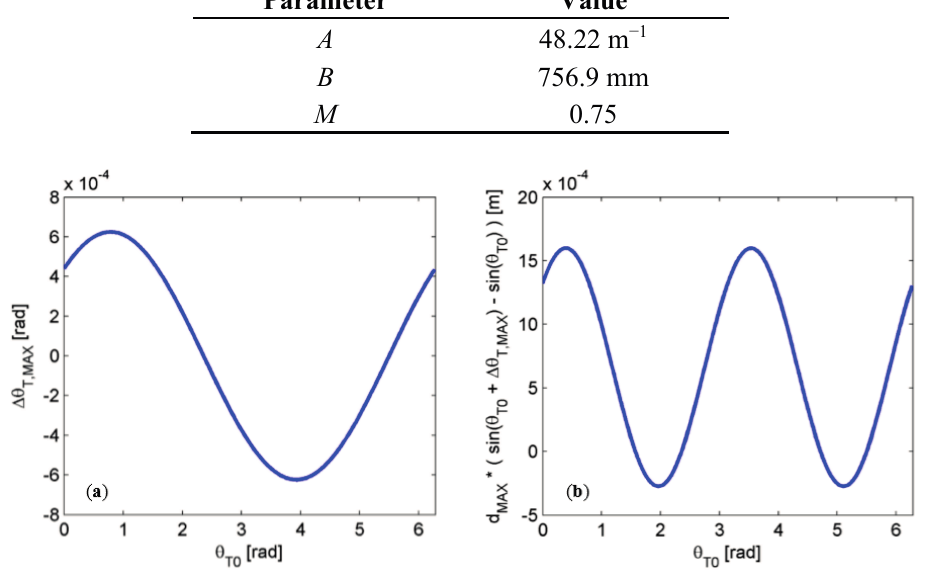
Figure 6. ( a ) Angular component of the maximum measurement error at d MAX = 3 m as a function of the estimated angle θ T 0 ; ( b ) Maximum estimated shift, due to the presence of angular uncertainty Δθ T,MAX , in the computation of the y -coordinate of the point P C at d MAX equal to 3 m